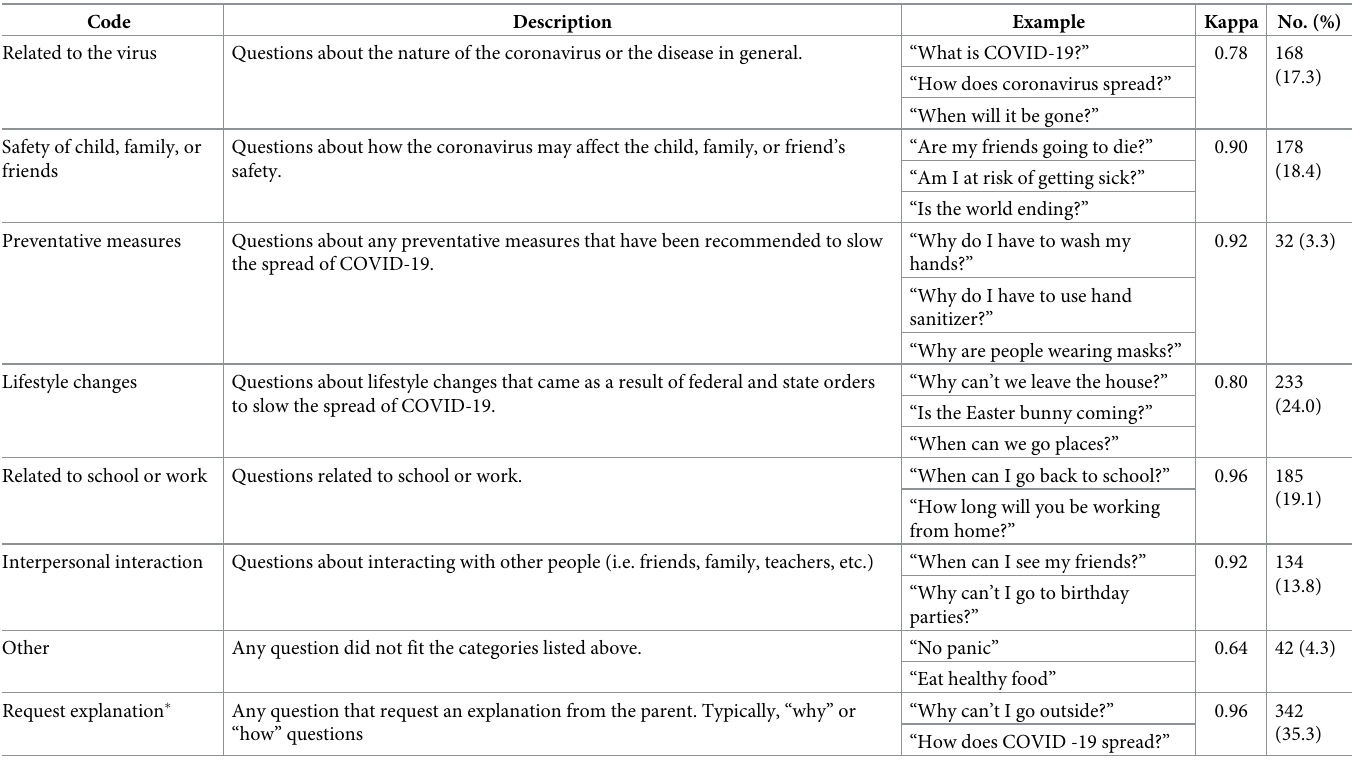
Table 2. Coding of children’s